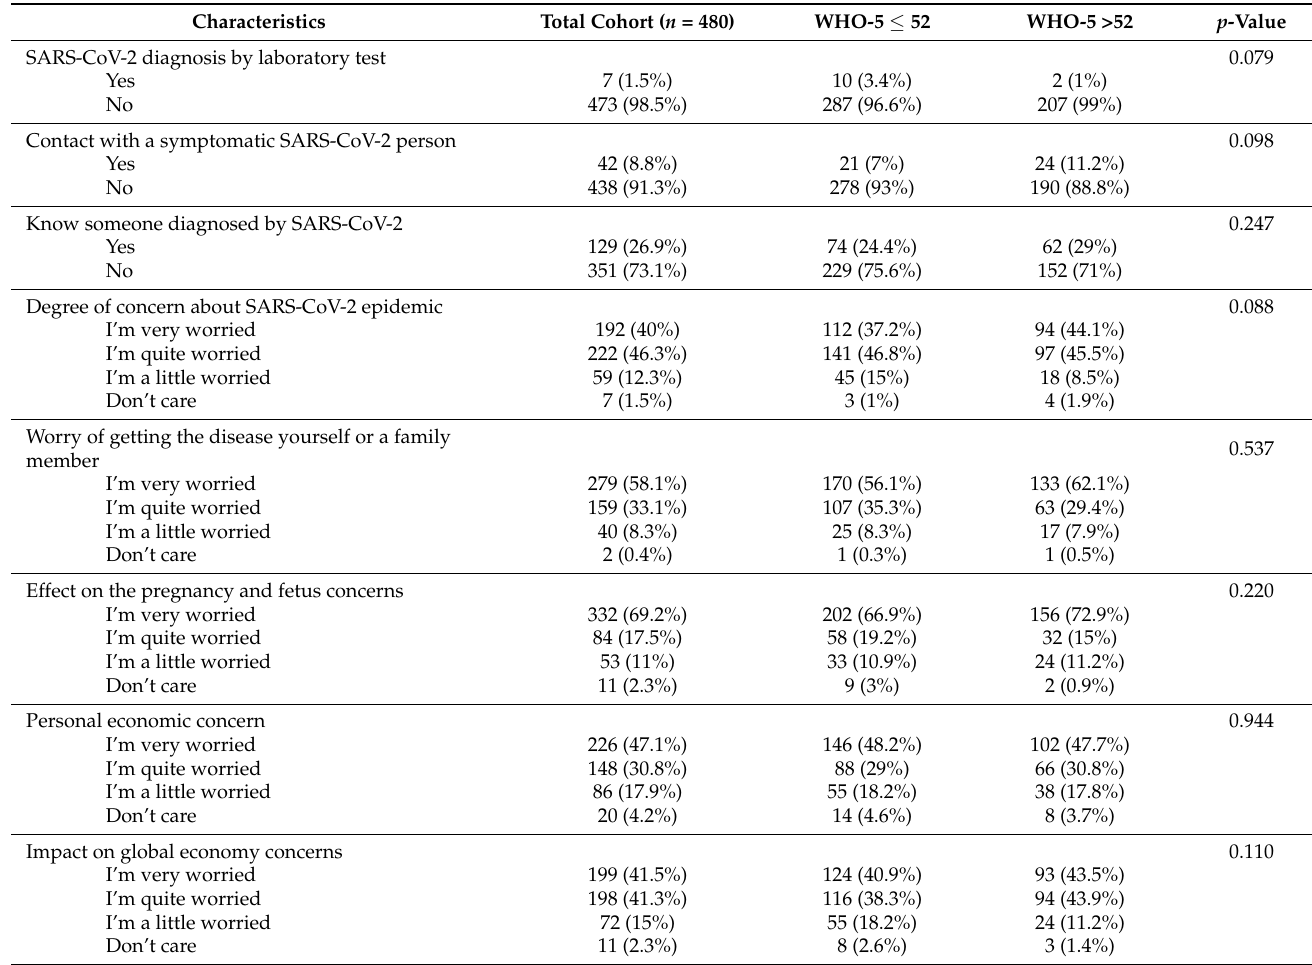
Table A2. Self-administered questionnaire on COVID-19 pandemic-related